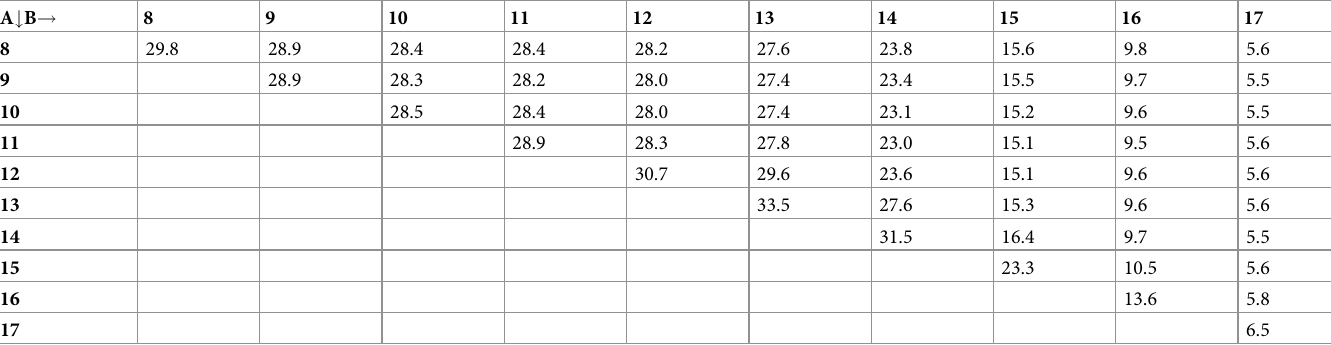
Table 1. Average error (in mm) for forecasting the mature height for boys using the height values beginning at age A and ending at age B.